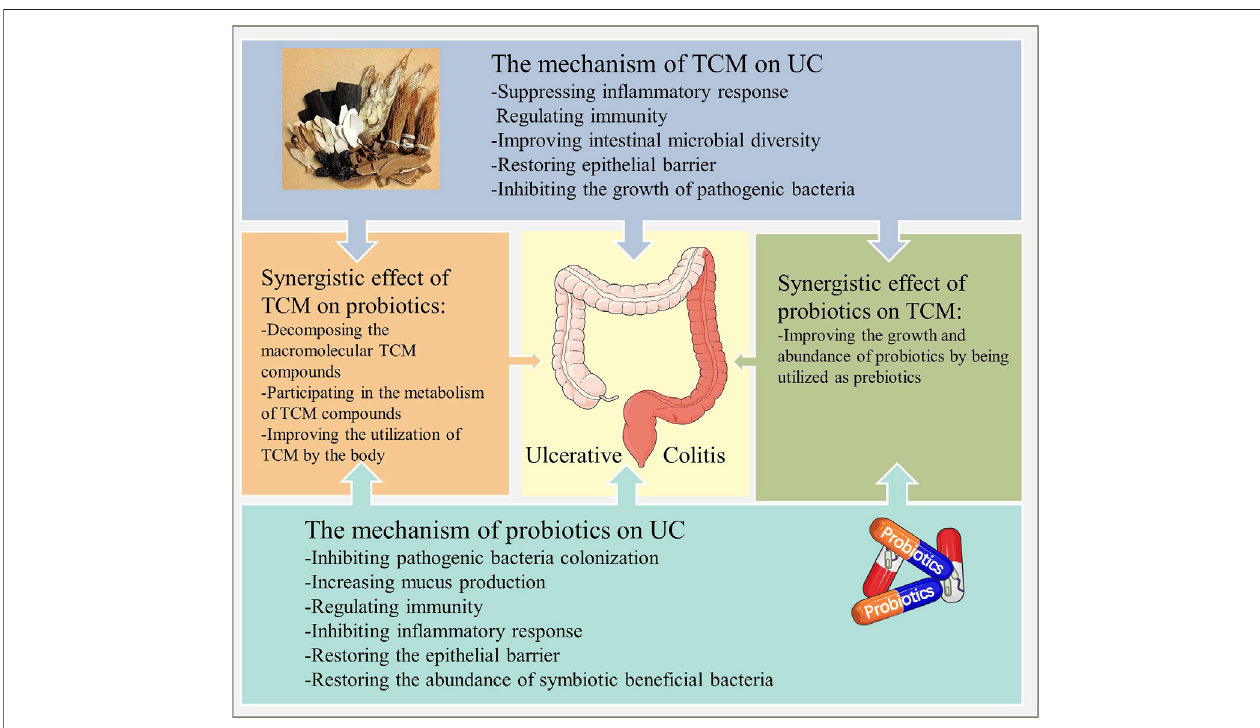
FIGURE9| ThemechanismofactionofprobioticscombinedwithTCMforUC.ProbioticsandTCMexerttherapeuticeffectsthroughtheirrespectiveactions,while the interaction between them re fl ects the synergistic effect and necessity of this combination.